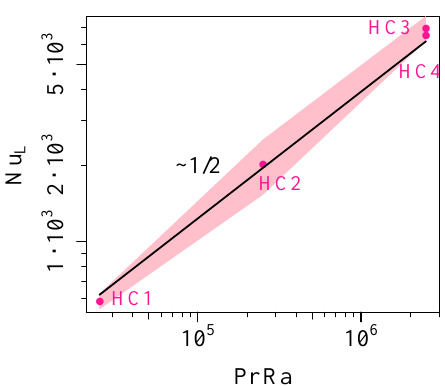
Figure 5. The scaling of the Nusselt number with the product of Prandtl and Rayleigh numbers. The shaded region indicates one standard deviation of the instantaneous Nusselt number above and below the time-averaged value.